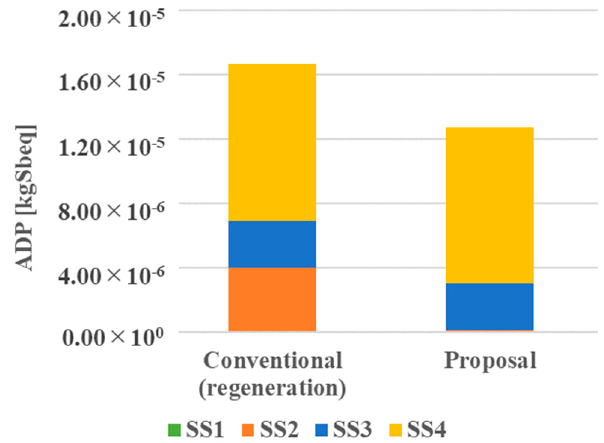
Figure 11. ADP results of the conventional (regeneration) and proposed cases.